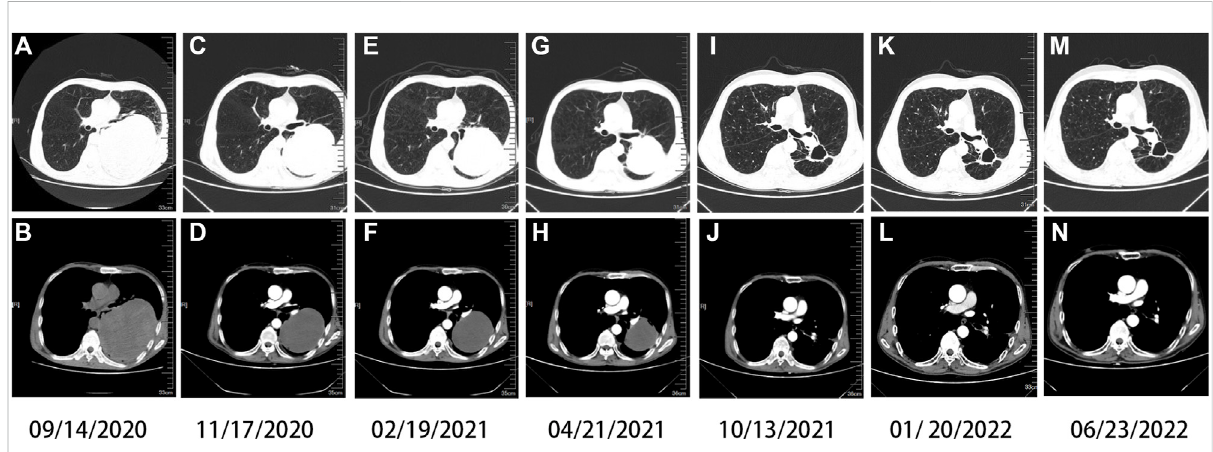
FIGURE 3 Chest computed tomography (CT).Imaging fi ndingsduring the patient ’ s course (A,B) at baseline (solid tumor,dmax =13.2 cm× 11.1 cm), (C,D) after one cycle of Tislelizumab and two cycles of chemotherapy (solid tumor, dmax = 11 cm × 8.7 cm), (E,F) after three cycles of Tislelizumab (solid tumor, dmax = 9.5 cm × 8.1 cm), (G,H) after fi ve cycles of Tislelizumab (solid tumor, dmax = 7.4 cm × 7.0 cm), (I,J) after ten cycles of Tislelizumab (cavity,dmax=3.9 cm×3.2 cm),and (K,L) afterthirteencyclesofTislelizumab(cavity,dmax=3.6 cm×2.8 cm); (M,N) inrecentrecheck(cavity, dmax = 3.3 cm × 2.5 cm), Anlotinib is in continuous